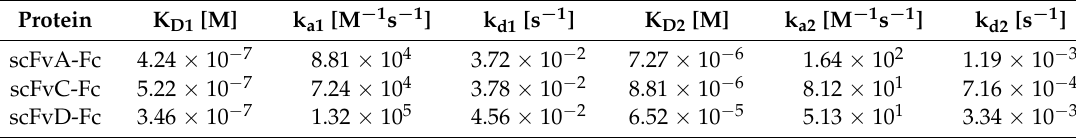
Table 2. Kinetic constants of the anti-FGF1 scFvs-Fc.